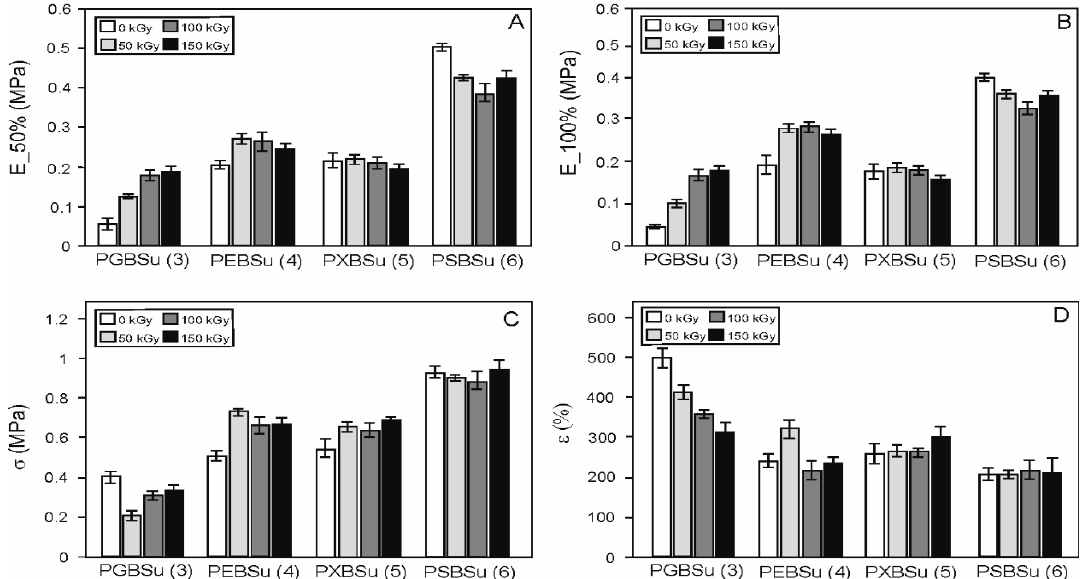
Figure 7. Mechanical properties of PGBSu, PEBSu, PXBSu, and PSBSu before and after irradiation. Tangent modulus at 50% elongation ( A ), tangent modulus at 100% elongation ( B ), stress at break ( C ), and elongation at break ( D ).